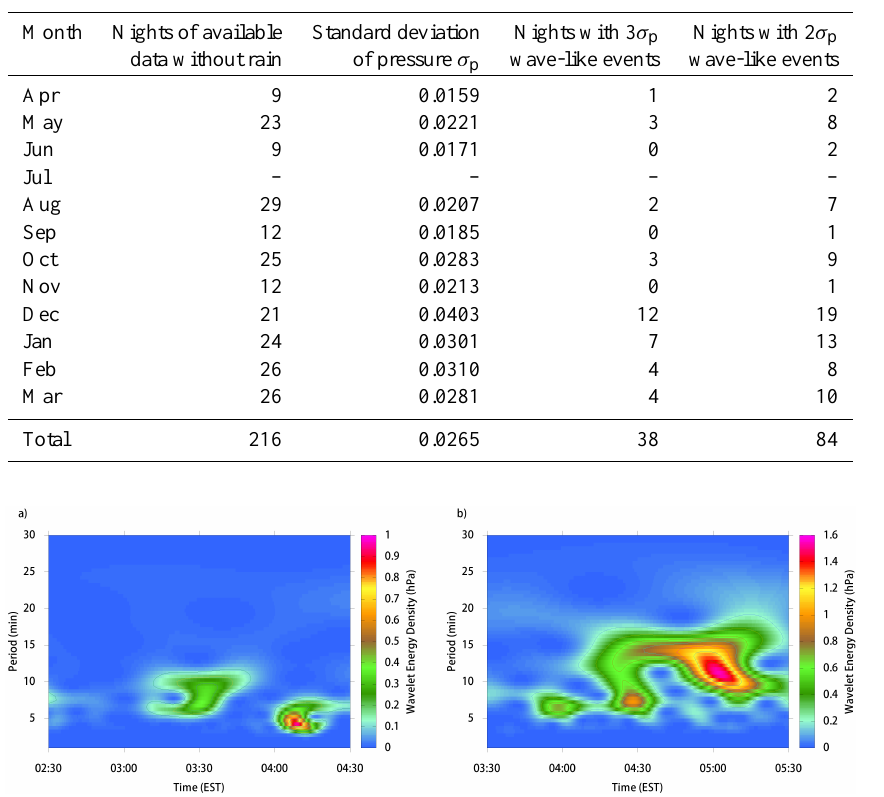
Table 1. Standard deviation of surface static pressure σ p and the monthly distribution of nights with 3 σ p and 2 σ p wave-like events.